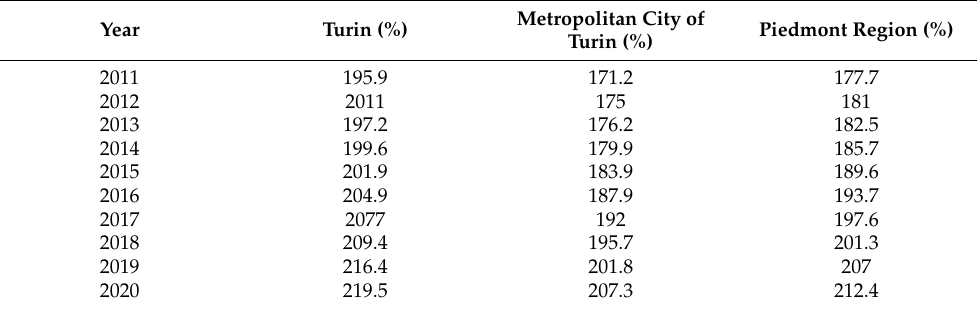
Table 7. Old age index for the City of Turin, the Metropolitan City, and the Piedmont Region from 2011 to 2020